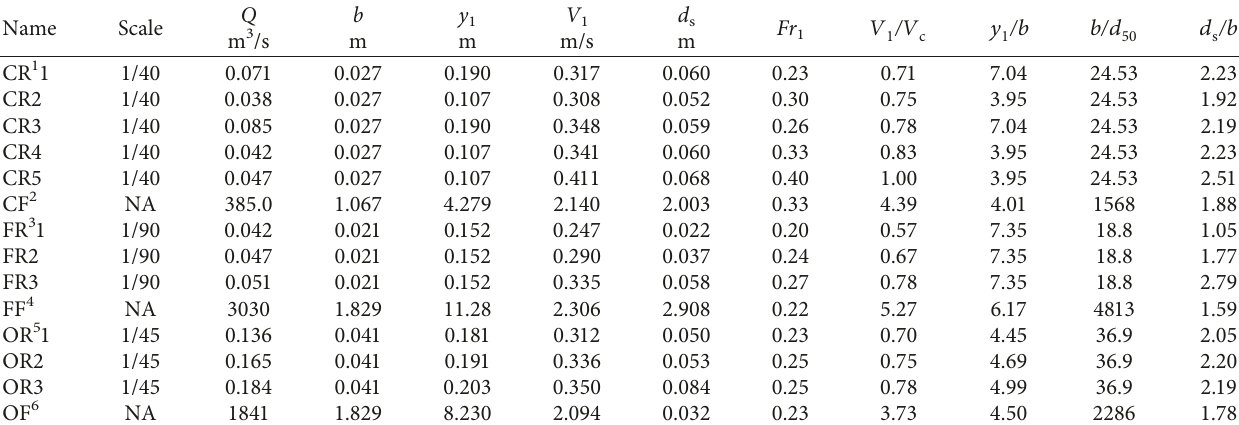
Table 1: Summary of experimental results and field data for each